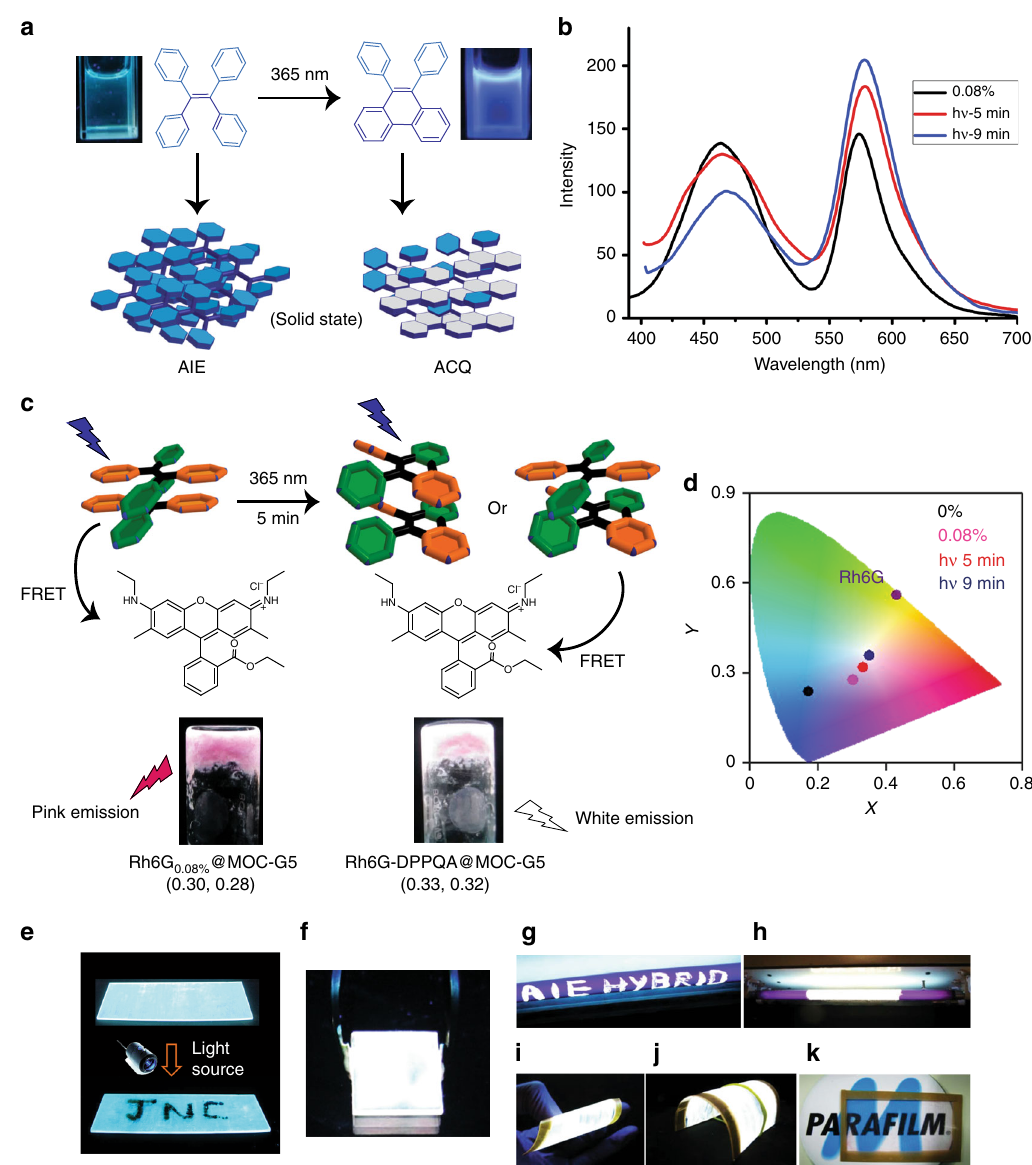
Fig. 6 Photomodulated white light emission in hydrogel. a A general schematic showing photocyclization of TPE (tetraphenylethene) to DPP (diphenylphenanthrene) on irradiation with 365nm light. b The emission spectrum of Rh6G 0.08% @MOC-G5 before photoirradiation (black), after 5min (red) and 9 min (blue) irradiation with 365nm light source. c Schematic showing the energy transfer pathways before and after photoirradiation. The corresponding CIE coordinates of Rh6G 0.08% @MOC-G5 and white-light-emitting gel ( Rh6G-DPPQA@MOC-G5 ) are mentioned below the respective hydrogel images. d Chromaticity diagram showing corresponding CIE coordinates of MOC - G5 (black), Rh6G 0.08% @MOC-G5 (pink), white-light-emitting hydrogel (red, form after 5min of photoirradiation on Rh6G 0.08% @MOC-G5 ), hydrogel (navy blue, form after 9 min of photoirradiation on Rh6G 0.08% @MOC-G5 ) and Rh6G (wine). e A glass slide coated with MOC - G5 hydrogel is irradiated with 365nm light to write ‘ JNC ’ . Processability of white-light-emitting hydrogel: f image of glass substrate coated with white-light-emitting hydrogel under UV lamp, g writing and h painting using same hydrogel on 365nm UV lamp. i , j Images of a fl exible plastic substrate (5×3 cm) coated with white-light-emitting-hydrogel under UV light and k under day